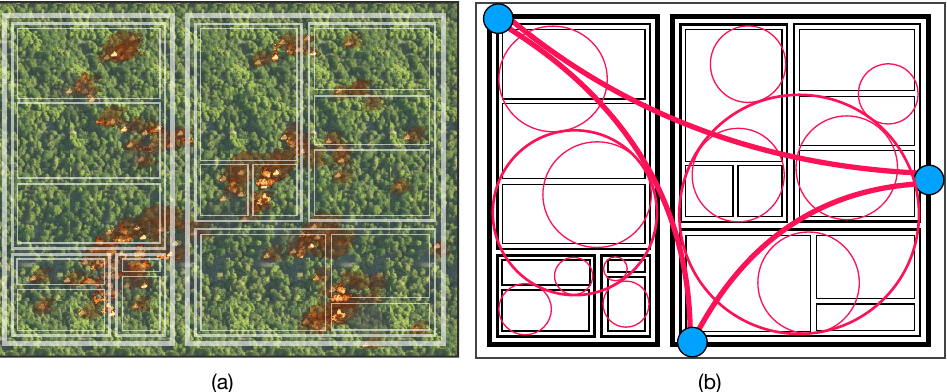
Figure 4. A self-adjusting options-induced skyway network. ( a ) The grid divides hierarchically into regions with the same number of interest-points at cells of the same level. ( b ) Options-induced trajectories move UAVs to different regions of each cell. Higher throughput trajectories occur at higher levels and are represented by thicker lines. Base-stations are denoted in